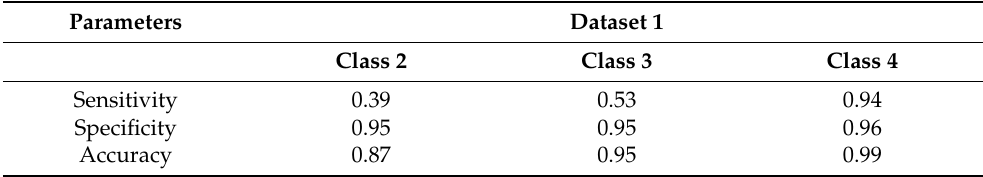
Table 4. Classification of diabetes for dataset